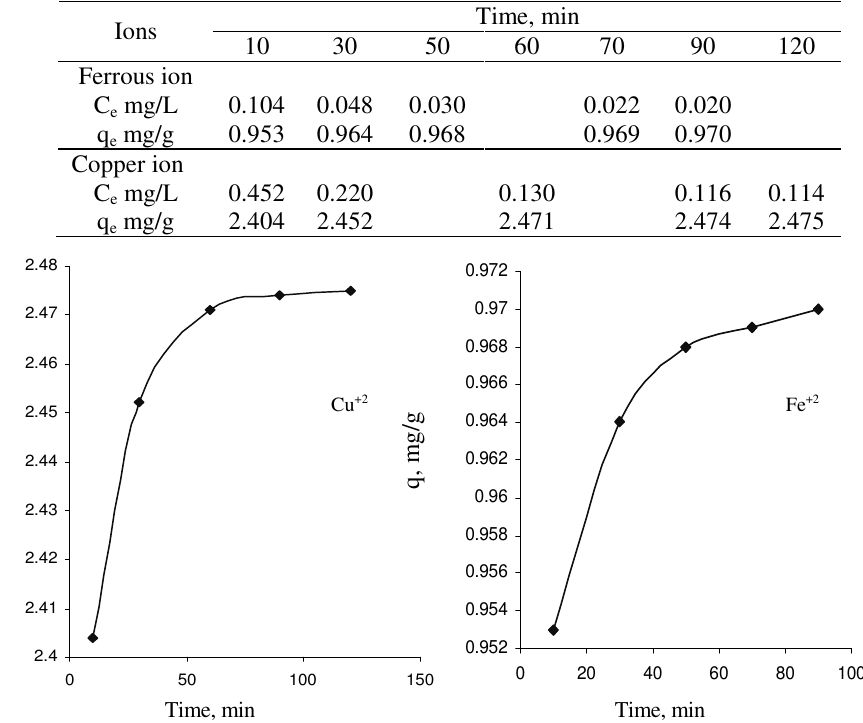
Figure 2 . Effect of contact time on copper and ferrous ions adsorption onto pine fruit